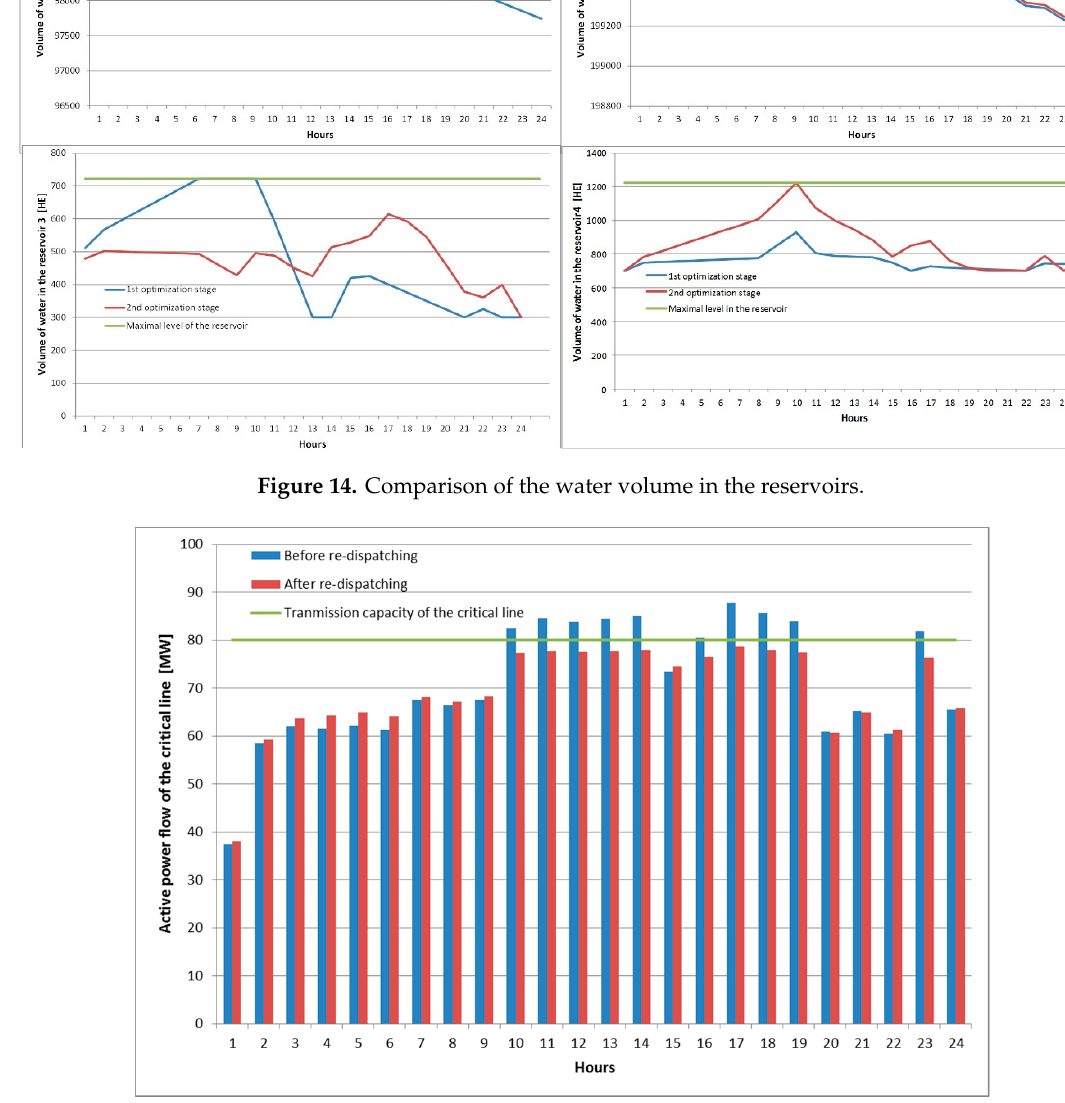
Figure 15. Comparison of the power flows on the critical transmission line with and without re- dispatching.